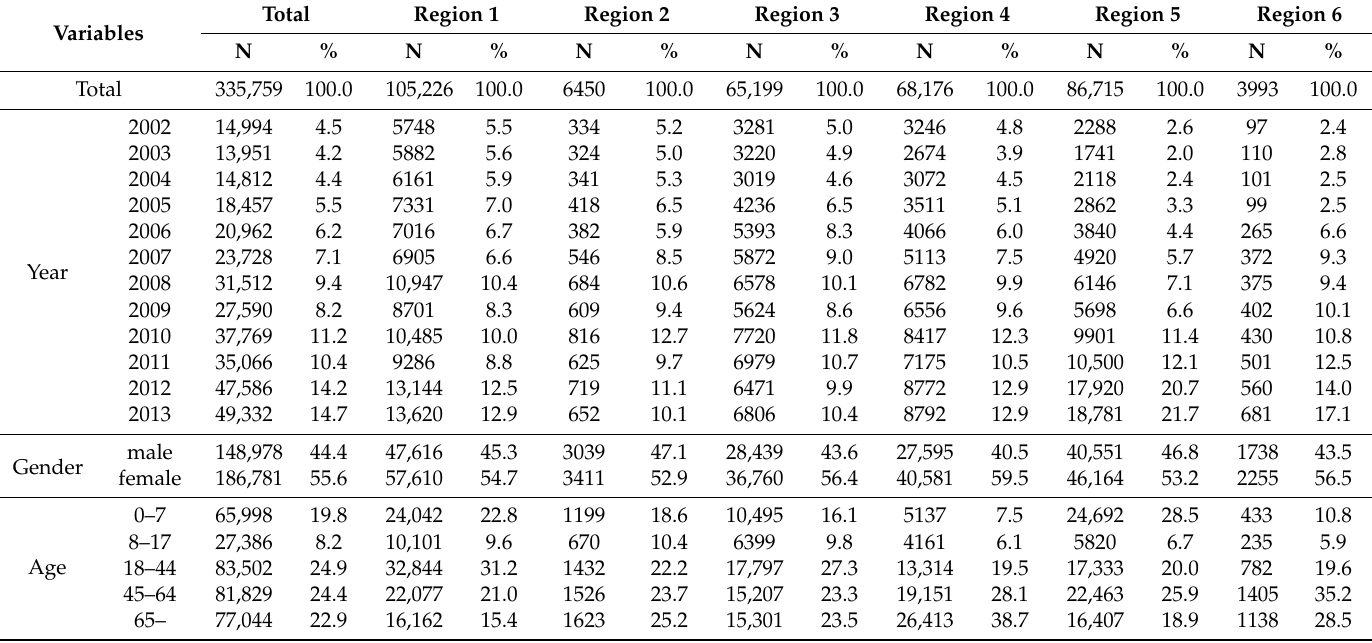
Table 2. Baseline characteristics of thermal illness patients from 2002 to 2013 in Korea.